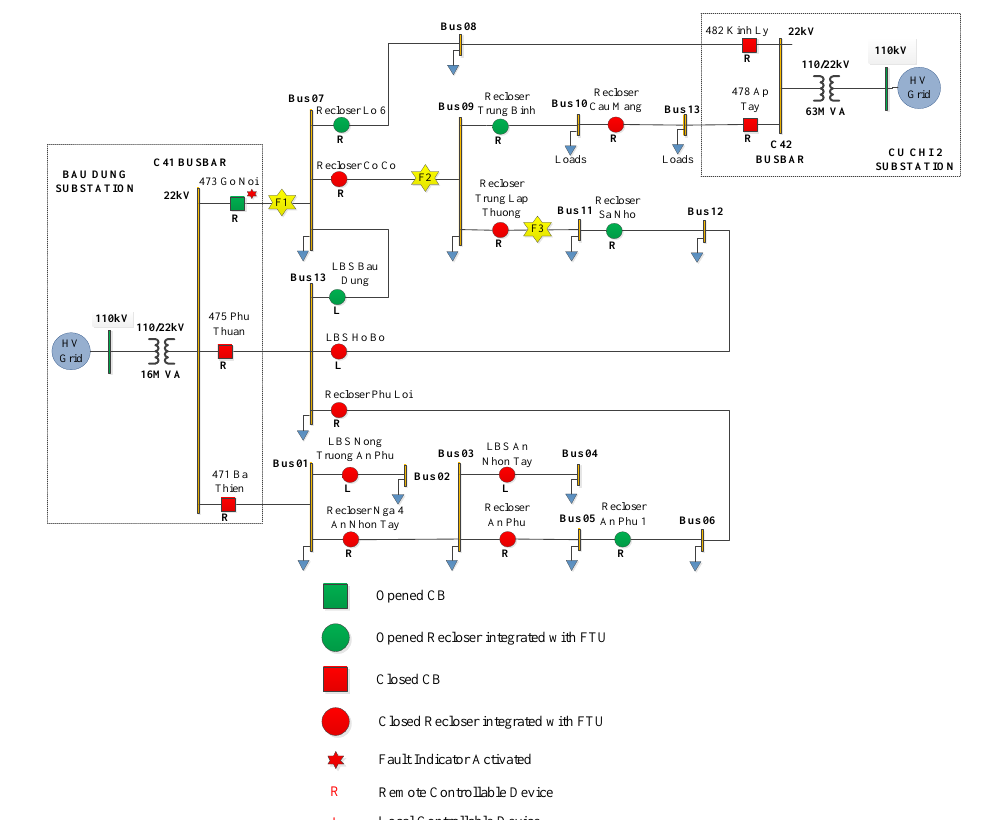
Figure 6. A single-line diagram of 22 kV distribution network with protective devices such as Reclosers, Load Break Switches, and Circuit Breakers and three different fault locations, F1, F2 and F3.